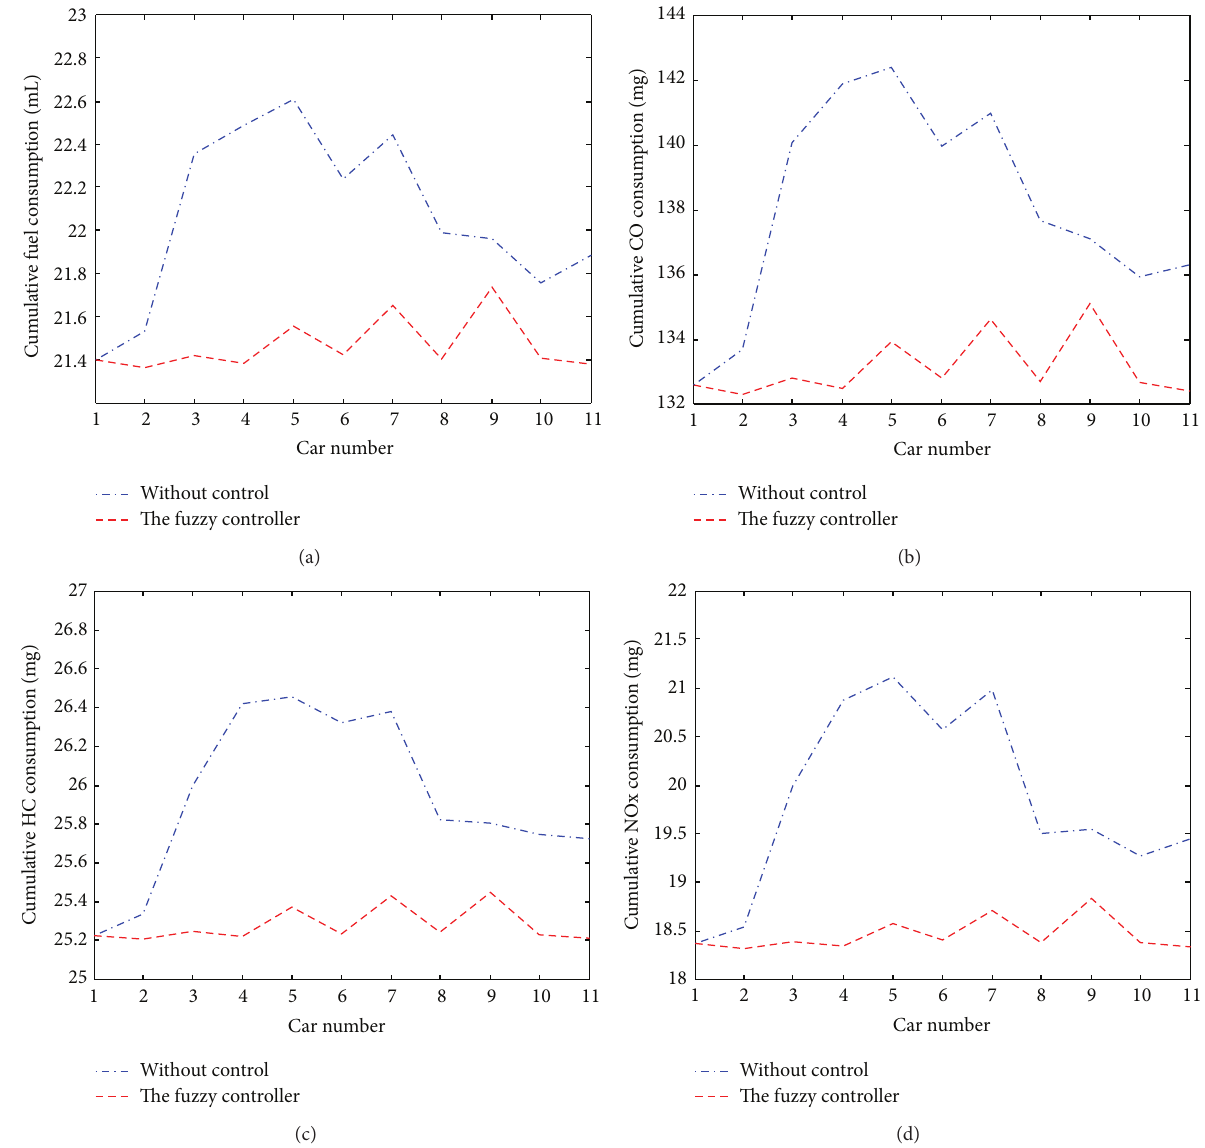
Figure 5: (a) Fuel consumption, (b) CO emission, (c) HC emission, and (d) NO 𝑥 emission of all vehicles during periods of 𝑡 = 140